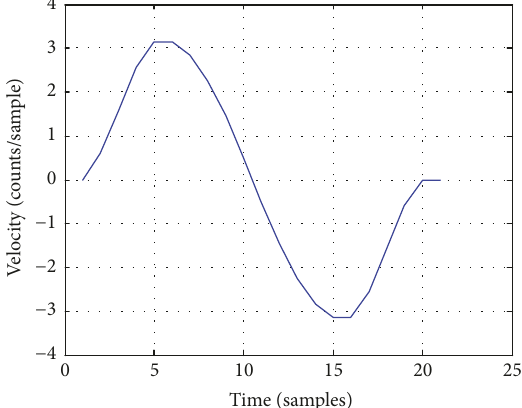
Figure 4: The velocity waveform of PMSM in continuous